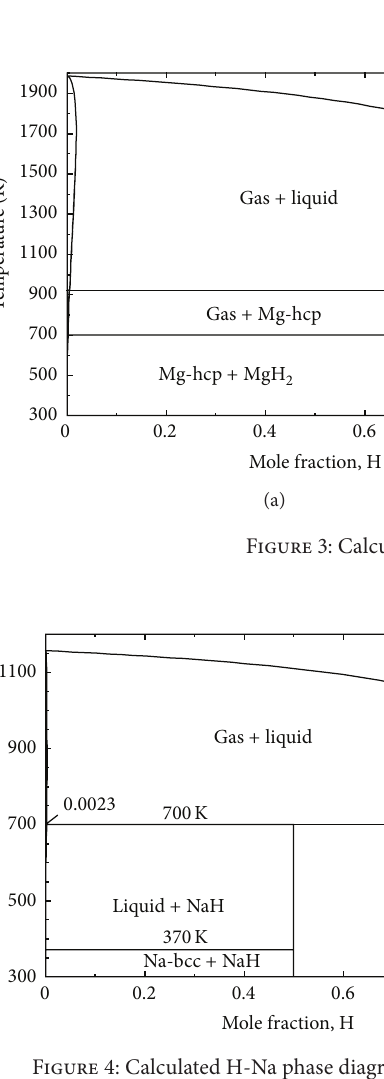
Figure 4: Calculated H-Na phase diagram at 1 bar.